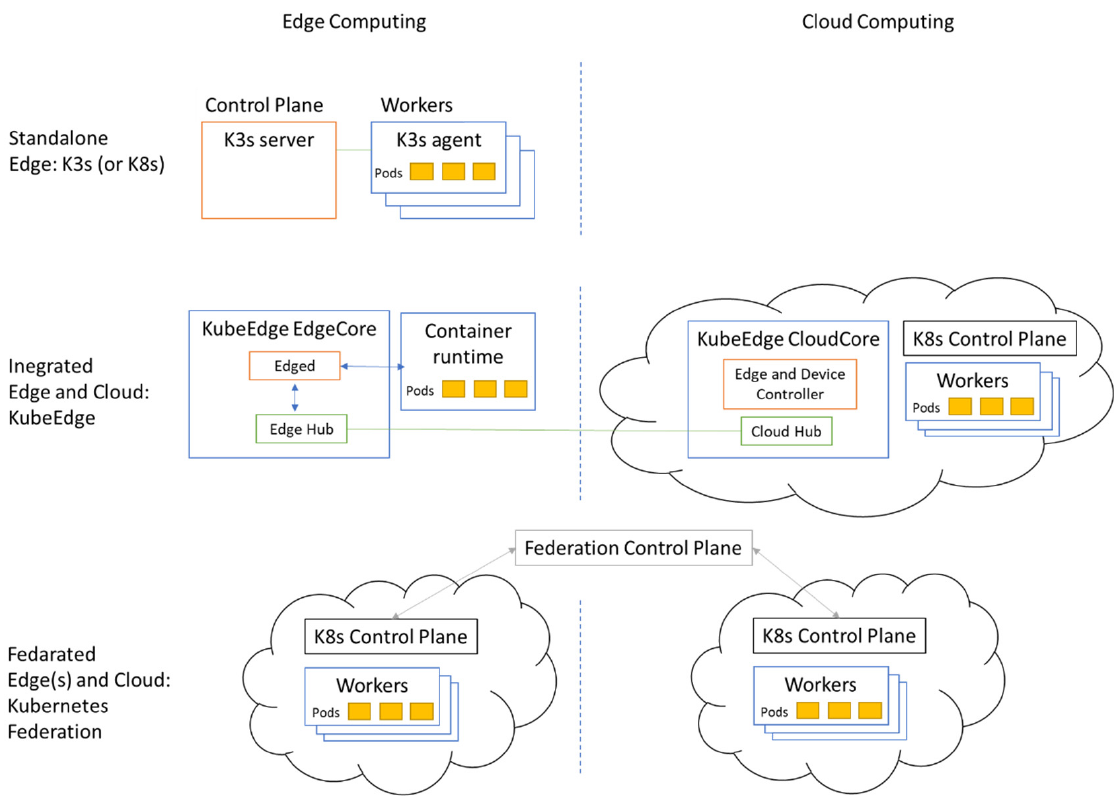
Figure 1. Edge and cloud scenarios with